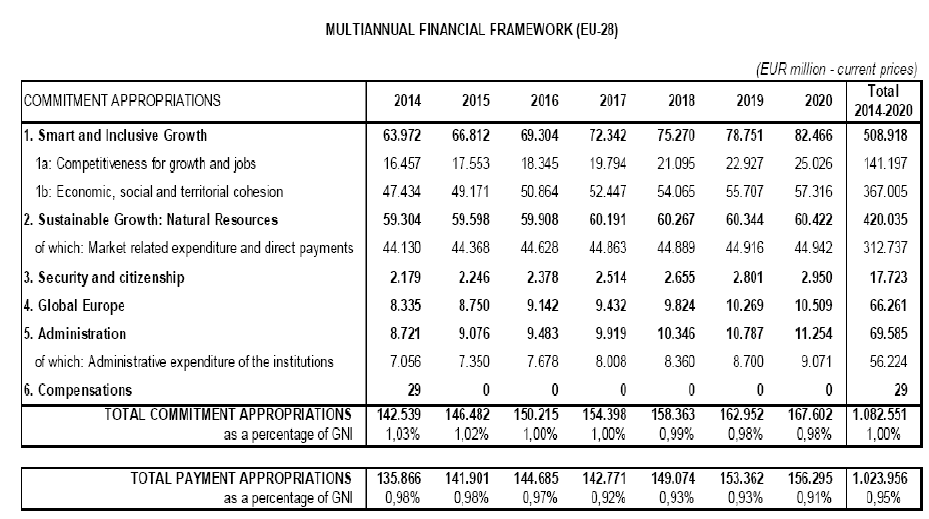
Table 3. MFF 2014-2020: commitment appropriations